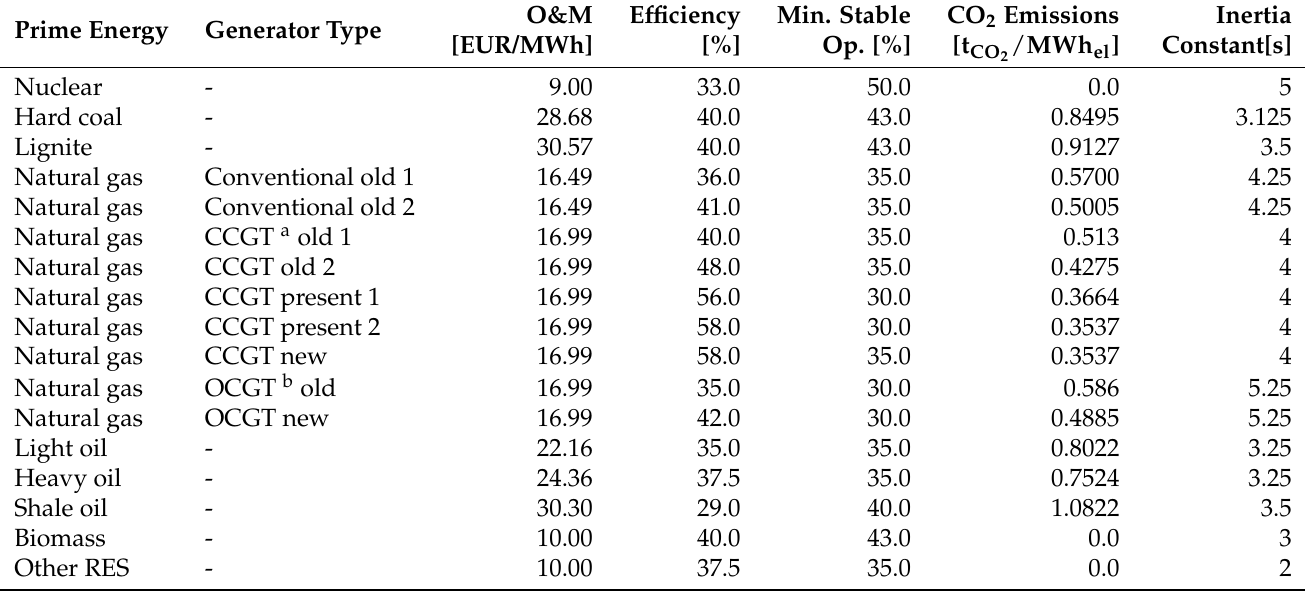
Table 3. Generator